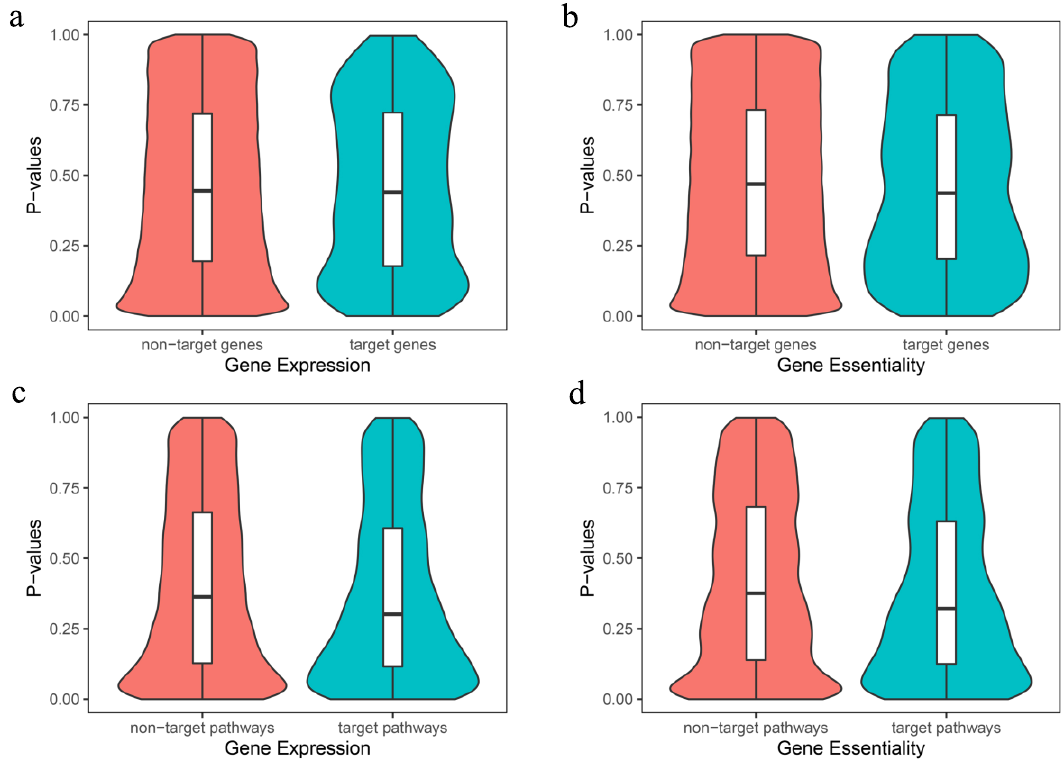
Figure 5. Violin plots of p -values for target and non-target genes ( a , b ) and pathways ( c , d ) using ( a ) gene expression, ( b ) gene essentiality, ( c ) gene expression, and ( d ) gene essentiality.